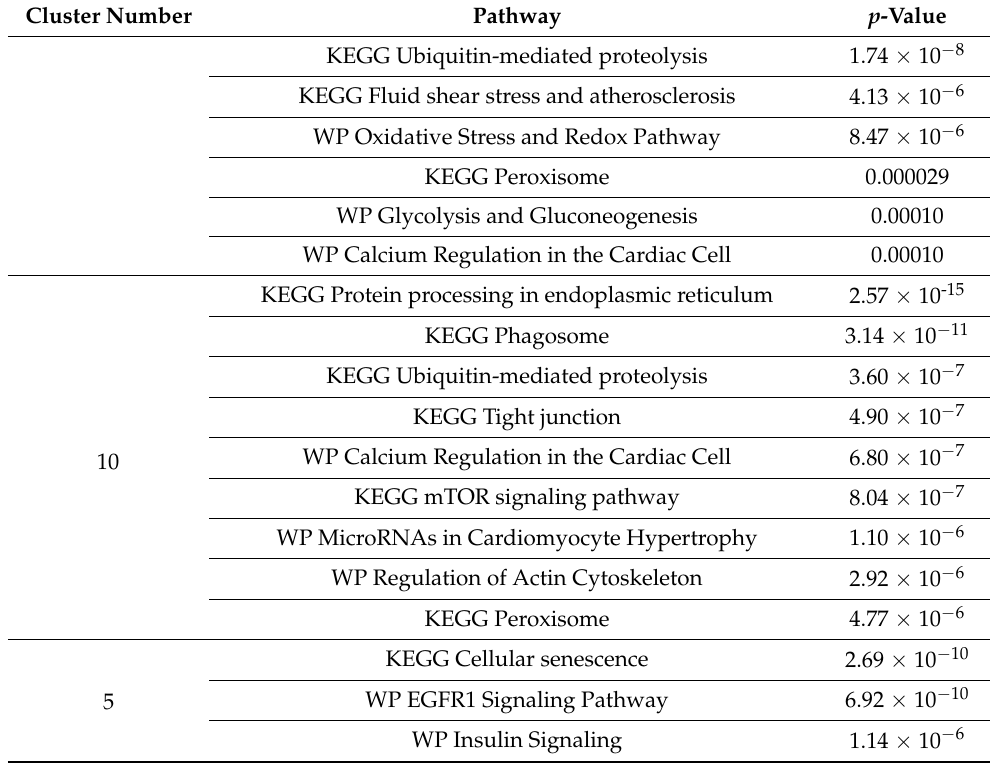
Table 2. GSEA results. KEGG and Wiki pathways were used to identify altered